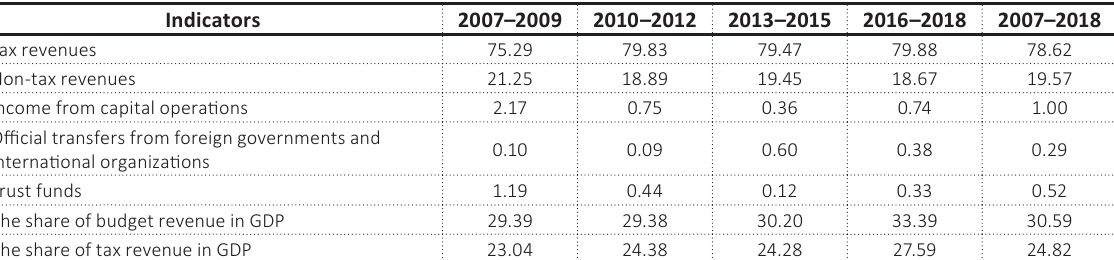
Table 2. The structure of consolidated budget of Ukraine and its share in GDP, %